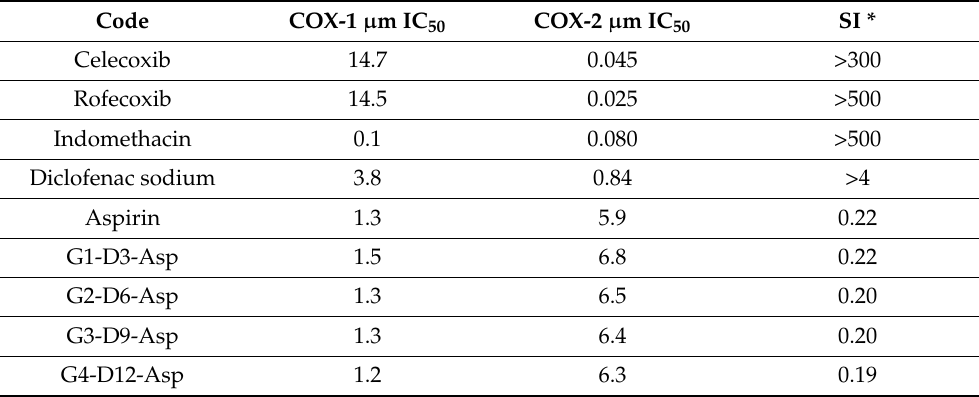
Table 3. IC 50 of inhibition of COX-1/COX-2 enzyme of the tested